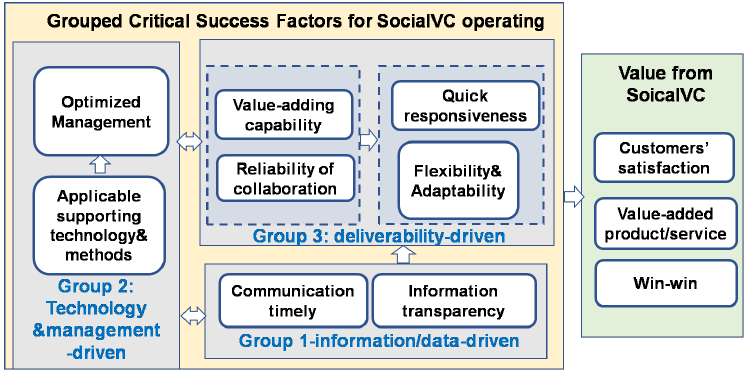
Figure 6. Grouped major CSF and relations with output from